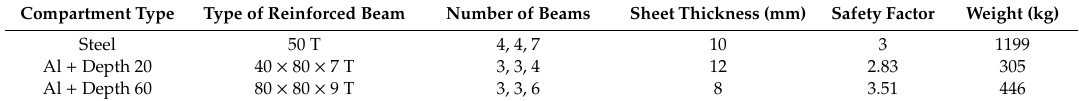
Table 7. Details of optimum design for different cases of compartments.